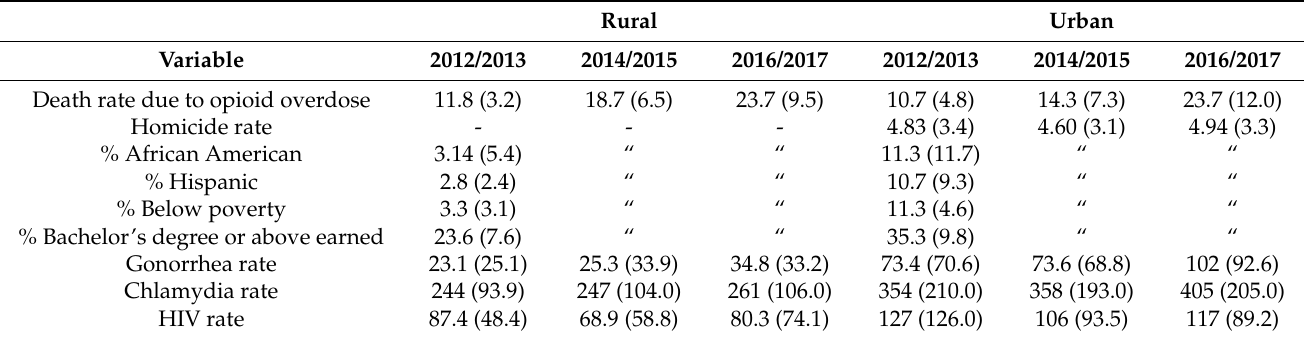
Table 1. Descriptive statistics of explanatory and model-dependent variables by year. Data is preScheme 100. persons, while the symbol “%” means percentage of the total population.